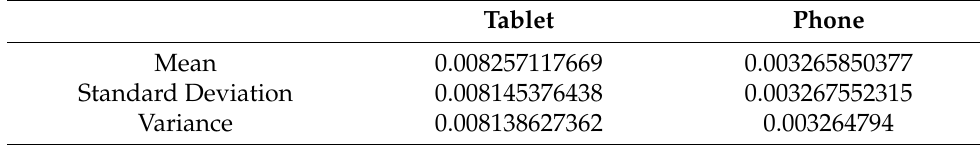
Table 2. Processing time for client devices